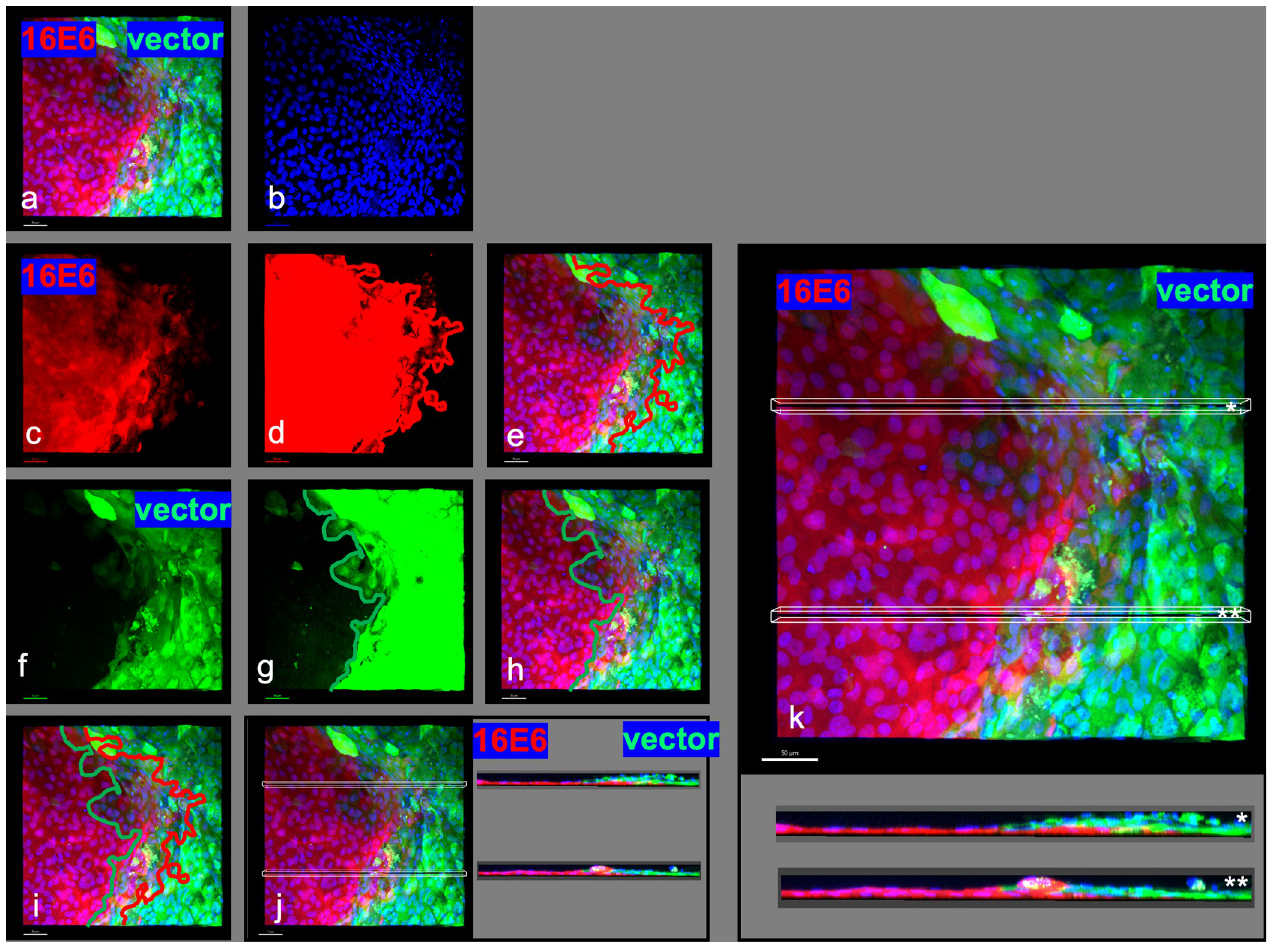
Fig 6. E6-expressing keratinocytes extend basally beneath normal keratinocytes, forcing the normal keratinocytes off the attachment substrate. HPV16 E6 expressing keratinocytes tagged in red were seeded at 0.1% and vector transduced keratinocytes tagged in green were seeded at 99.9% and cultured for 21 days as described in Fig 1. Confocal Images were captured with a 10X objective; the bar at lower left indicates 50 um. Blue color is DAPI stained DNA signal. Fig 6A. Three color image. Fig 6B. DAPI-stained. Fig 6C.! 6E6-transduced cells tagged with Fusion Red. Fig 6D. Overexposure of Fusion Red image with superimposed red line indicating the extent of 16E6 expressing cells. Fig 6E. Red line superimposed onto 3-color image to show the extent of 16E6 expressing cells. Fig 6F. EGFP signal indicating vector-transduced cells. Fig 6G. Overexposure of Fig 6F, with line to indicate extent of vector transduced cells. Fig 6H. Green line from G superimposed onto 3-color image. Fig 6I. 3-color image with red and green lines indicating area of overlapping red-16E6 and green-vector expressing cells. Fig 6J. Three-color image with white boxes indicating the location of z-plane image construction; z-plane images to the right show that 16E6 red cells are basal to vector-green cells. Fig 6K. The same Z-stack image reconstructions shown in Fig 6J are enlarged for clarity; asterix shows the corresponding image and